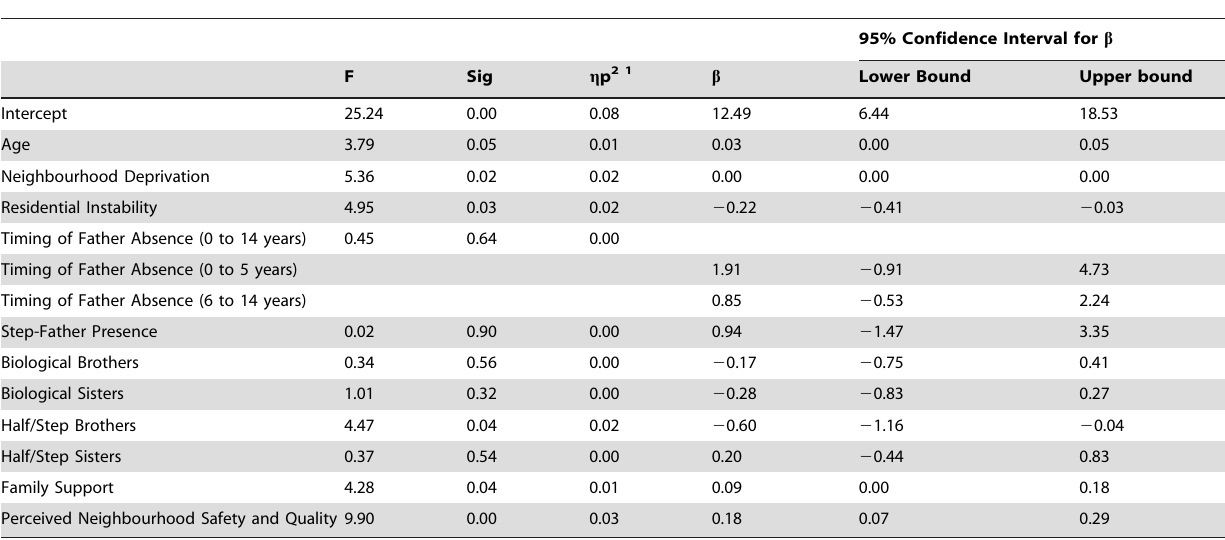
Table 4. Results of a univariate GLM for the childhood adversity variables plus age on intended reproductive timing.